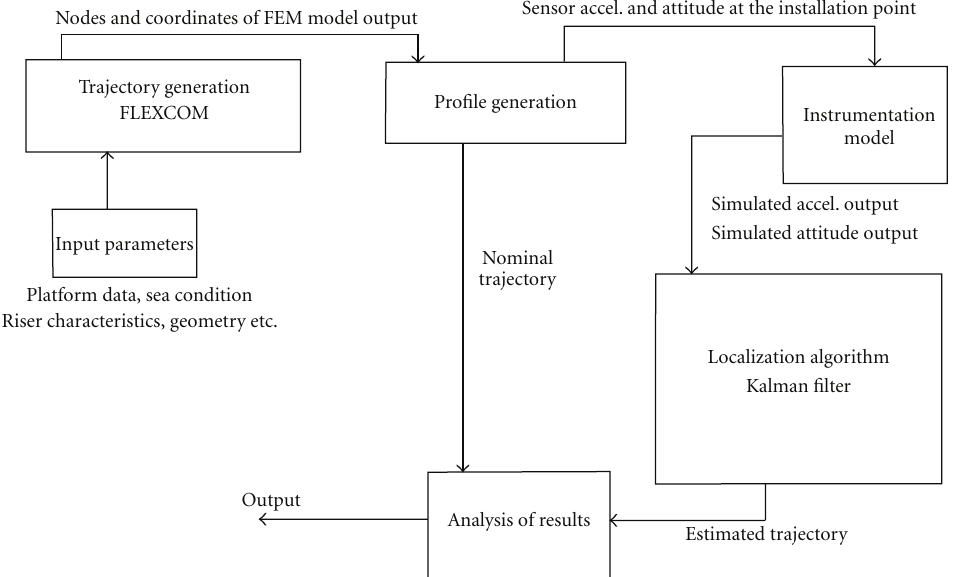
Figure 3: Overview of the system simulation analysis. A dynamic riser profile is generated through an FEM analysis. Using robot’s kinematical and instrumentation model, the expected sensor readings are used to reconstruct the riser profile by the localization algorithm, which is compared to the original profile from FEM